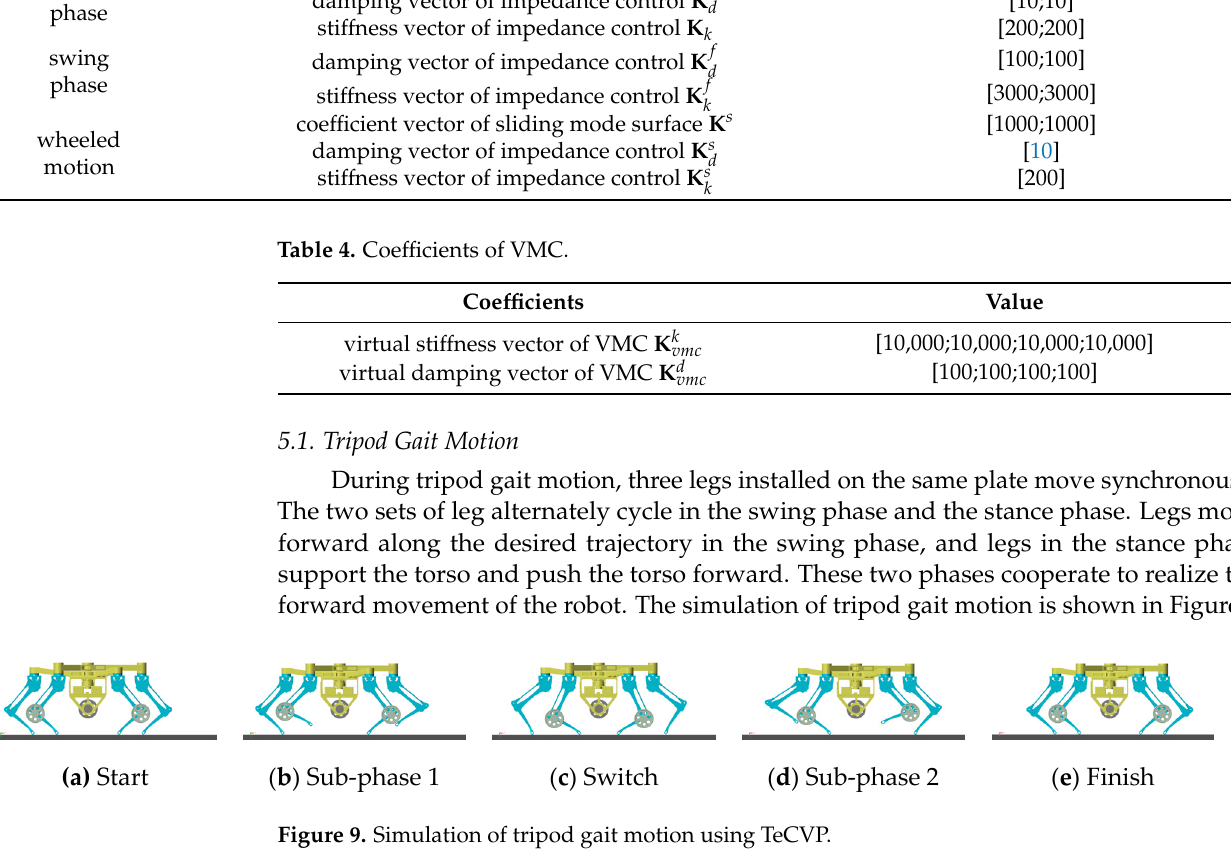
Table 4. Coefficients of VMC.